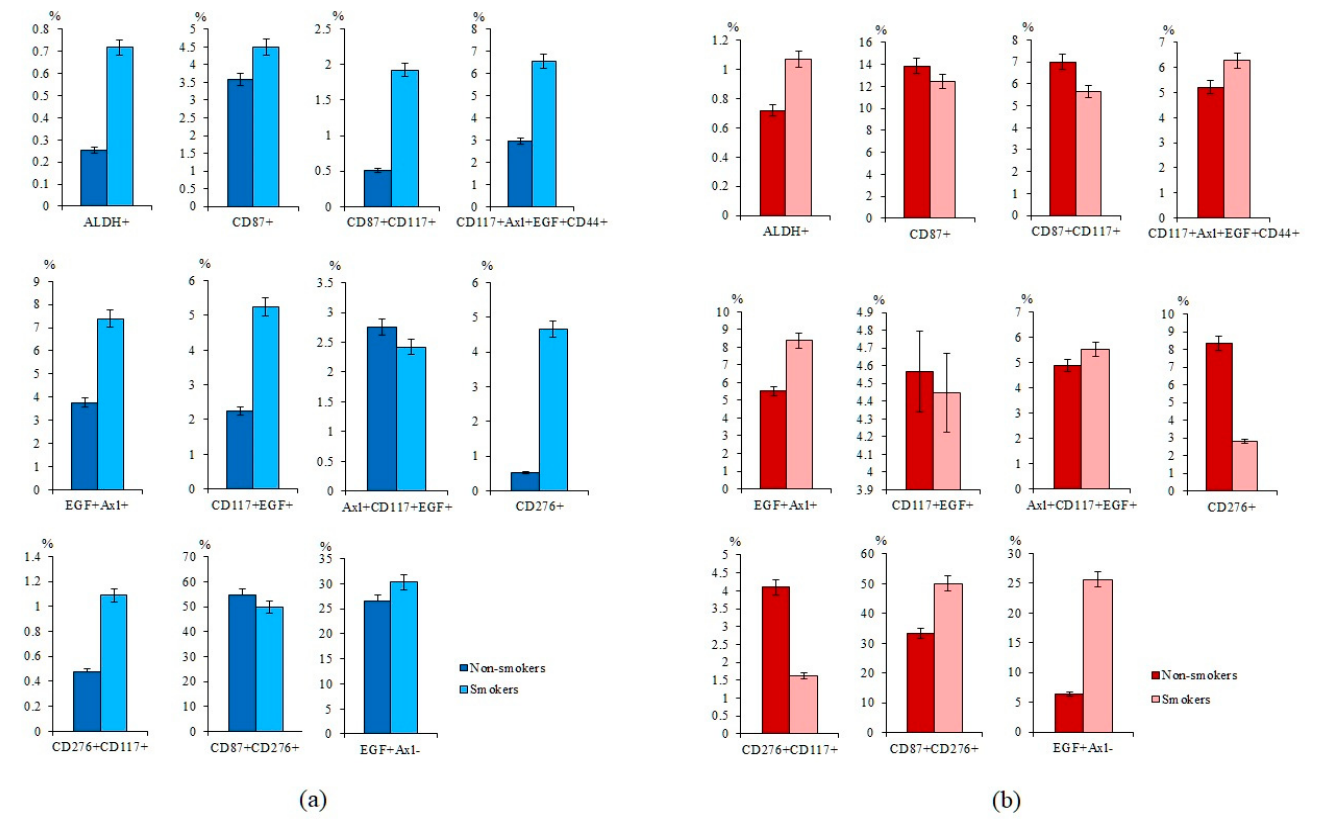
Figure 4. Characterization of circulating tumor cells (CTCs) isolated from the blood of non-smoking and smoking SCLC patients and healthy volunteers. Cells were analyzed by flow cytometry using antibodies against CD87, CD117, CD276, CD44, Axl, EGF, and ALDH1. The level of CD87 + , CD87 + CD117 + , CD117 + Axl + EGF + CD44 + , EGF + Axl + , CD117 + EGF + , Axl + CD117 + EGF + , CD276 + , CD276 + CD117 + , CD87 + CD276 + , and EGF + Axl − CTCs in the blood of ( a ) non-smoking and smoking healthy volunteers and ( b ) non-smoking and smoking patients with SCLC (% of all labelled mononuclear cells).